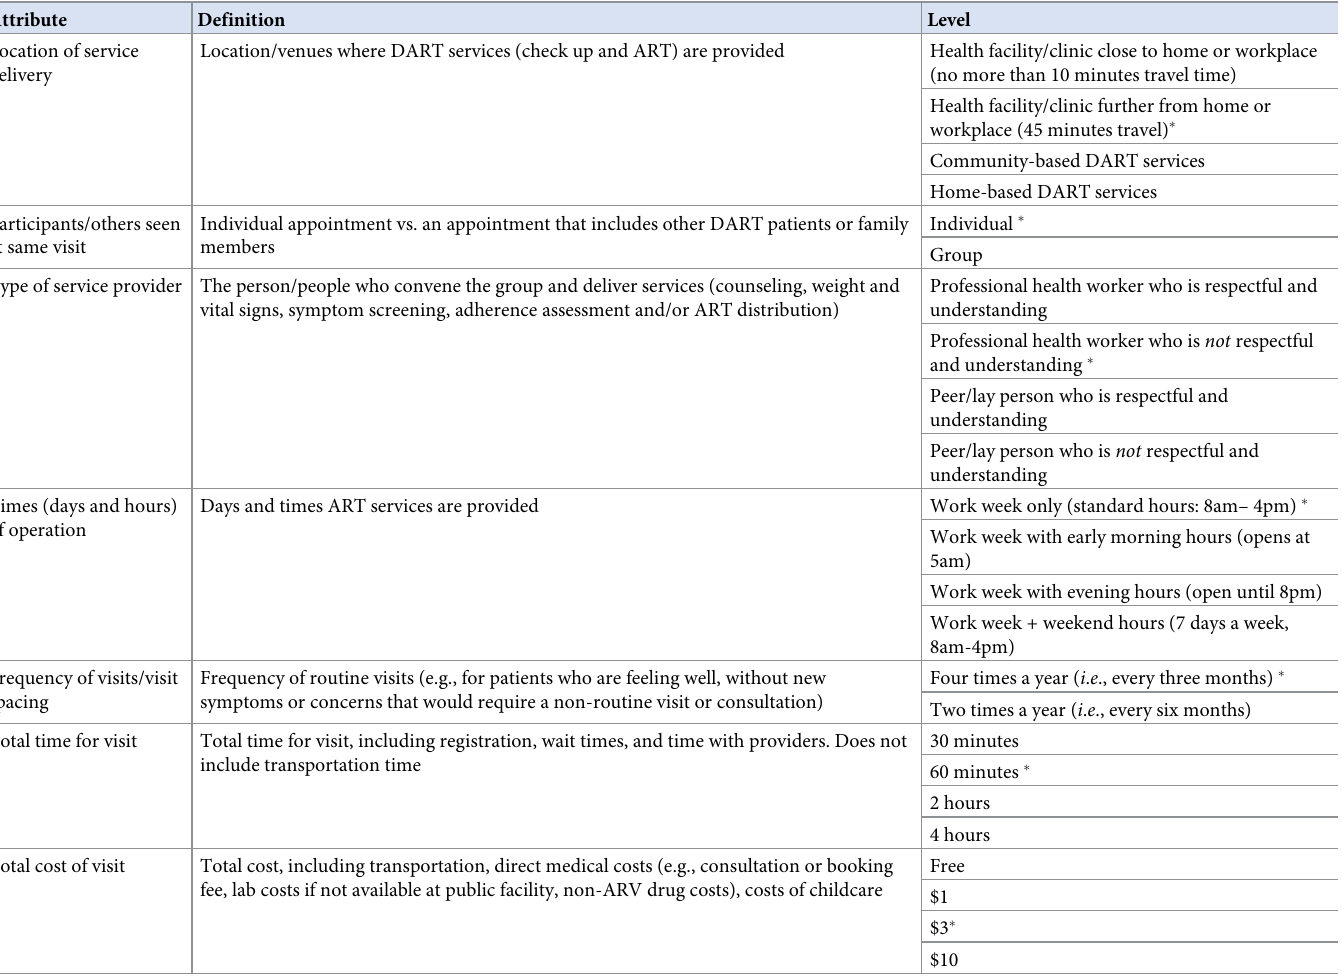
Table 1. Discrete choice experiment attributes and